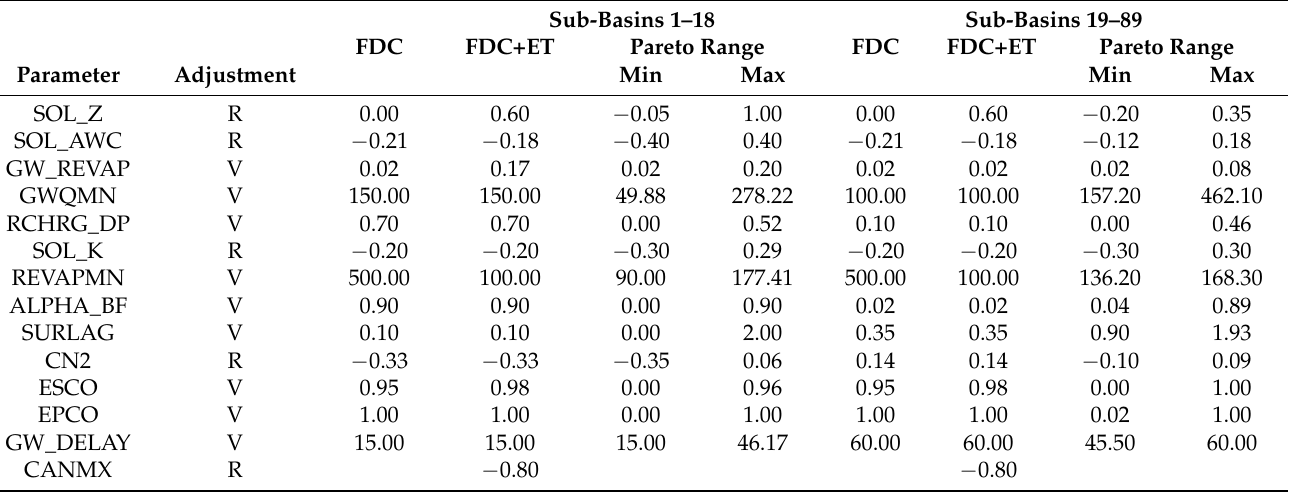
Table 5. Calibrated SWAT parameters using streamflow signatures (FDC), streamflow signatures and remote sensing-based evapotranspiration (FDC + ET) and automatic multi-objective calibration (Pareto